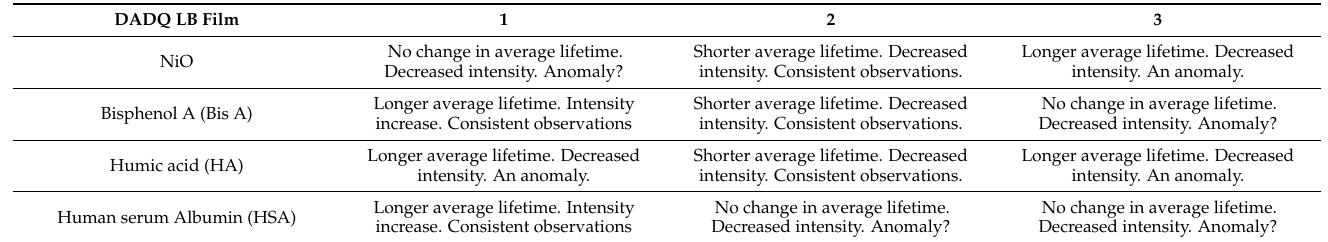
Table 2. A summary of observations and conclusion for target analyte exposure to pristine LB films. The input is drawn from Figures 6 and 7. Consistency refers to modulation of average fluorescence lifetime and integrated intensity being congruent. See text for